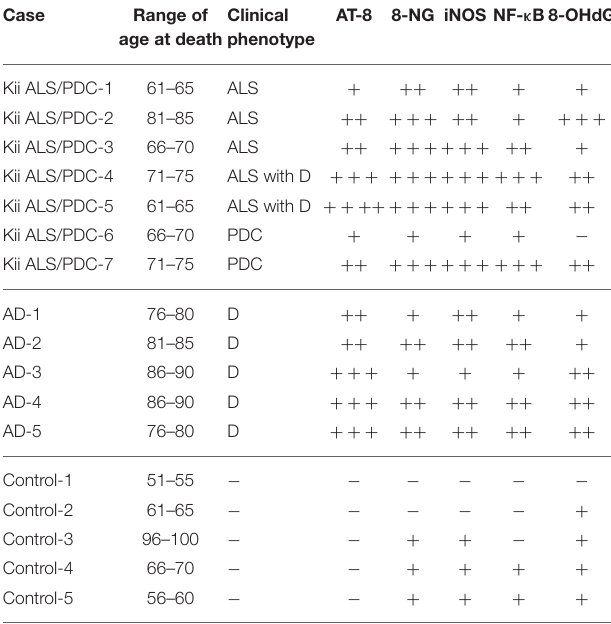
TABLE 1 | The quantitative assessment summary of the immunohistochemistry in the hippocampus of Kii ALS/PDC patients, Alzheimer’s disease patients and